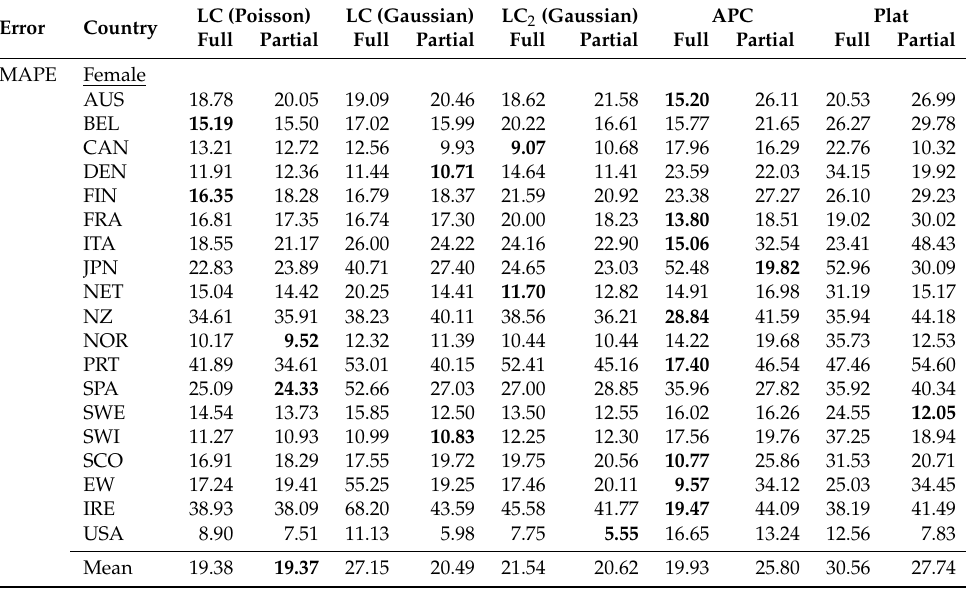
Table 4. For the 30-step-ahead forecast horizon h = 30, we compute the MAPE and RMSPE for each country and each model. The most accurate model for each country is highlighted in bold. For each model, we consider modeling the data with either a partial age range (termed as Partial) or a full age range (termed as